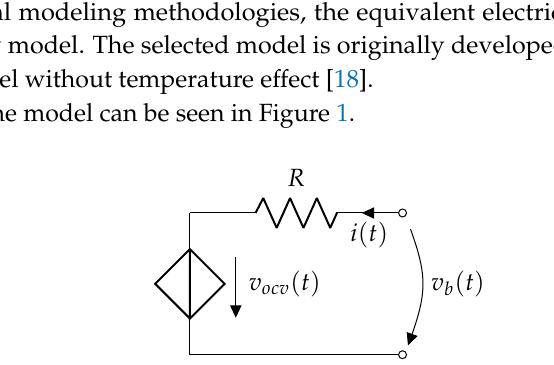
Figure 1. Equivalent electrical circuit model of the battery. Voltage v ocv ( t ) of the controlled voltage source is different in the case of charge and